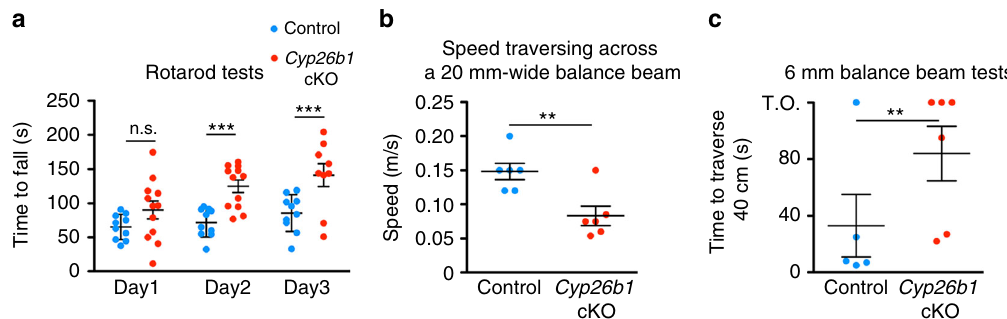
Fig. 8 Impaired coordination of Cyp26b1 cKO mice on balance beam. a Quanti fi cation of rotarod tests. Each mouse was placed on a rotating rod, which accelerated from 5 to 40 r.p.m. over a 5-min period. Cyp26b1 cKO and Foxg1 Cre ;Cyp26b1 lox/ + controls exhibited similar motor performance on day 1 of the trial (90.3 ± 15.9 s in mutants, n = 10, vs. 65.3 ± 6.5 s in controls, n = 10, P = 0.2573). Cyp26b1 cKO mutants were able to stay on rod longer than controls on the second day of testing (123.3 ± 11.0 s mutants vs. 71.7 ± 7.5 s controls, P = 0.0003) and third day (141.2 ± 17.8 s mutants vs. 85.7 ± 9.5 s controls, P = 0.0037). The two-way ANOVA with multiple comparisons was applied. b Quanti fi cation of speed to traverse 60 cm distance on a 20-mm-wide beam. Cyp26b1 cKO mutants moved slower (0.083 ± 0.014 m/s, n = 6) than controls (0.148 ± 0.011 m/s, n = 5, P = 0.0056, unpaired t test). c Quanti fi cation of time taken to cross 40 cm distance on a 6-mm-wide beam. Half of Cyp26b1 cKO mutants failed to traverse the beam in 2 min (3/6), whereas most of controls reached the endpoints within 30 s (4/5). By assigning 2 min for all the mice that failed to complete the 40 cm distance, Cyp26b1 cKO mutants moved slower (taking 84.0 ± 19.24 s to traverse the beam) than controls (33.0 ± 22.04 s for controls, P = 0.0099, unpaired t test). Error bars: SEM. ** P < 0.01 and *** P < 0.001. TO, time out; n.s., not signi fi